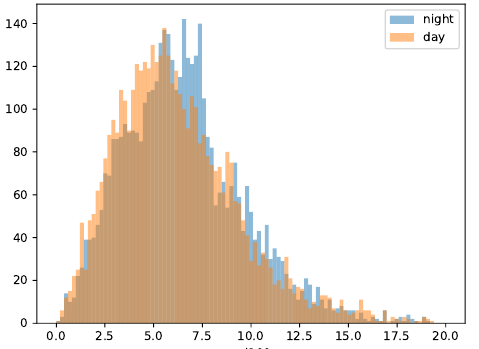
Figure 6. Histograms of the velocity of wind at 100 m derived from NWP data for the year 2016 and measured in m/s during the day and night in